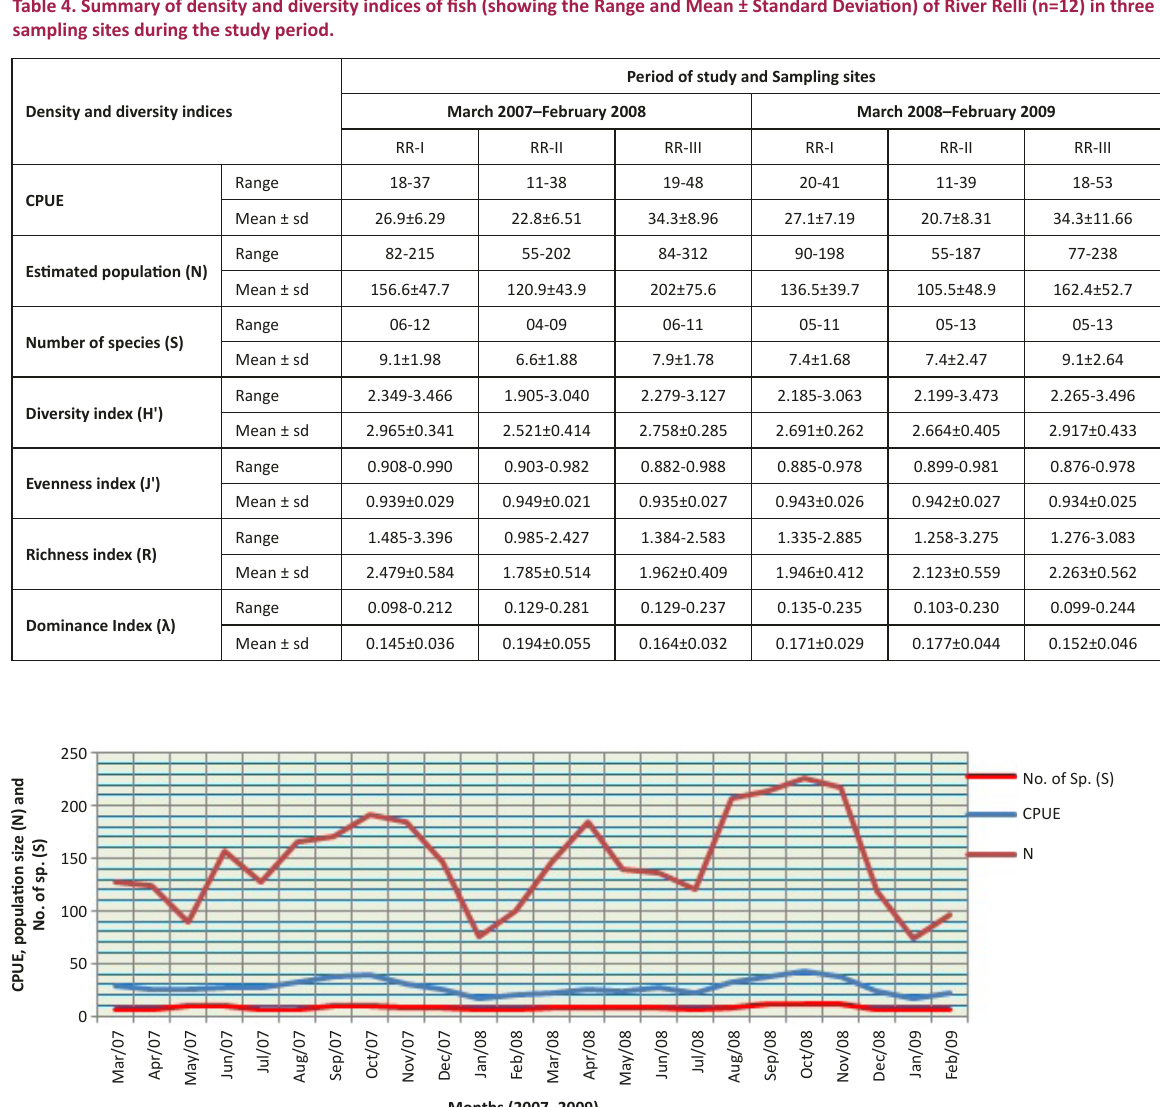
Table 4. Summary of density and diversity indices of fish (showing the Range and Mean ± Standard Deviation) of River Relli (n=12) in three sampling sites during the study period.